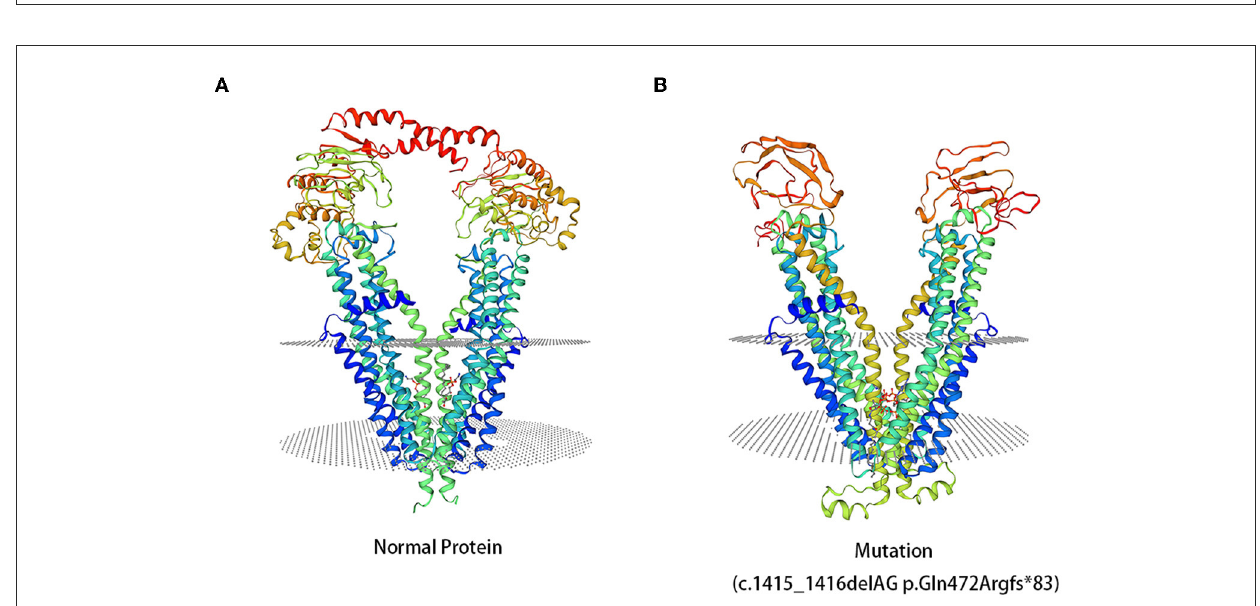
FIGURE4 3D computer model (SWISS-MODEL) shows the predicted structures of the ABCD1 protein. (A) The predicted structures of the normal ABCD1 protein. (B) The predicted structures of the ABCD1 protein carrying the mutation of c.1415_1416delAG